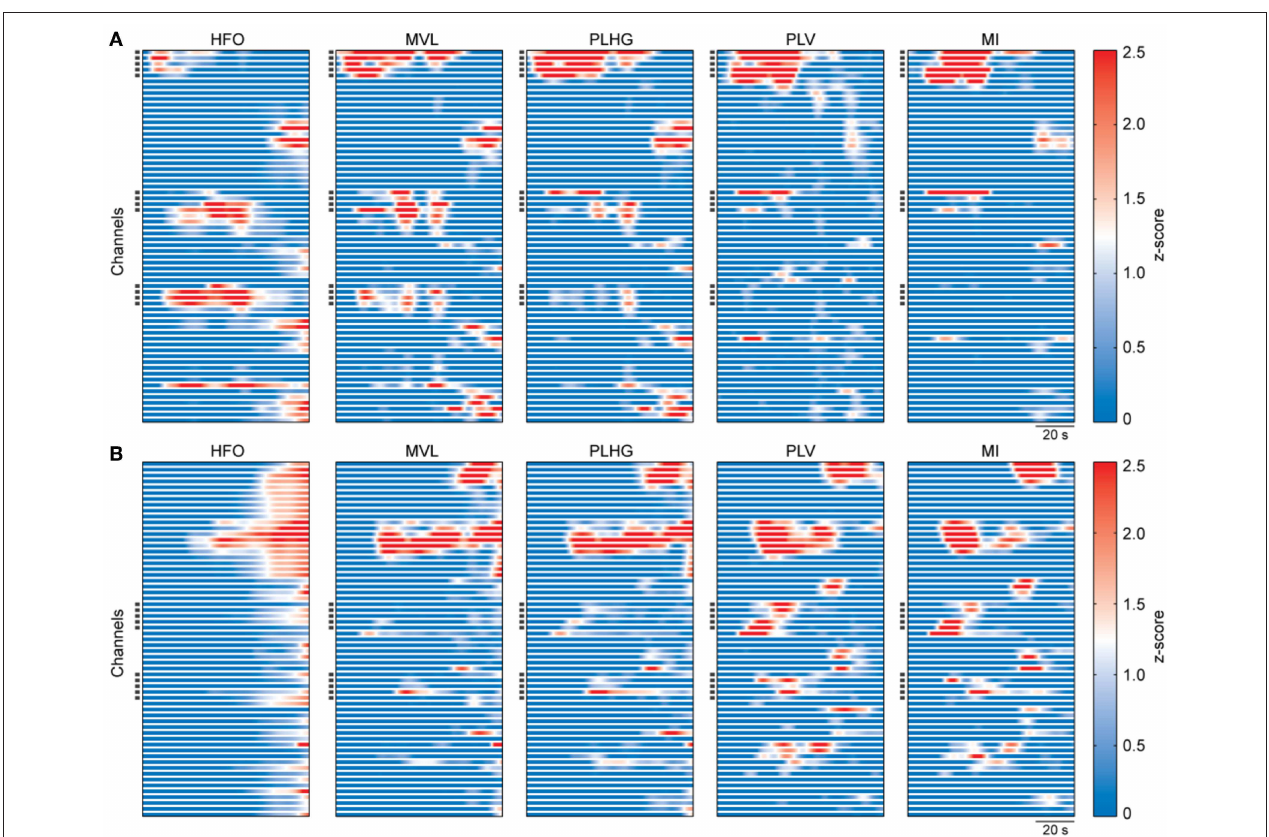
FIGURE 2 | Representative examples of estimated measures during seizures. (A) Calculated measures from intracranial EEG recordings of a patient with outcome Engel I. The graphs show the whole seizure, from onset to termination. The measures were obtained using a moving window of 3s with 333ms moving step, and then smoothed using a 20-sample moving window. Values of each graph were z-scored using all channels and ictal time segments of the representative seizure. Each horizontal line represents one channel. Dark squares on the y-axis indicate the resected channels during surgery. (B) Same as (A) , but for a patient with outcome Engel IV.